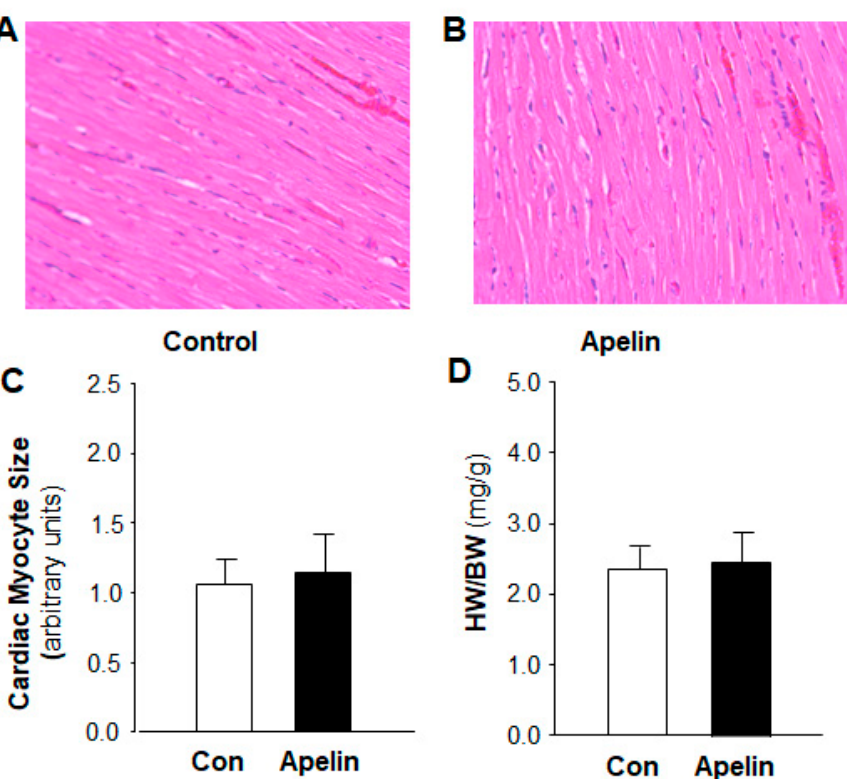
Figure 2. Effect of chronic subcutaneous infusions of apelin on cardiac morphology. The cardiac morphology was examined using H&E staining in the heart sections of rats that received chronic treatment with control (saline) and apelin-13 for two weeks. ( A , B ), micrographs (magnification, 20X) showing representative heart sections stained with H&E in rats that received subcutaneous infusion of saline or [pyr 1 ]-apelin-13. ( C ), bar graphs summarizing the cardiac myocyte area within the cardiac sections in each group of rats. Data are means ± SE from 6 rats in each group ( p > 0.5). ( D ), bar graphs showing the ratio of heart weight versus body weight (HW/BW) in rats that received subcutaneous infusion of saline or [pyr1]-apelin-13. Data are means ± SE from 6 rats in each group ( p > 0.5). It has been reported that APJ receptors share a 31% amino acid sequence identity with AT1 receptors [6]. Therefore, we examined the possibility that apelin could interact with Ang II/AT1 receptors by detecting the chronic effect of apelin on the Ang II-induced pressor response. The results from this experiment are presented in Figure 3, demonstrating that subcutaneous infusions of apelin-13 did not significantly alter Ang II-induced increases in MAP, SAP, DAP, and PAP. Chronic subcutaneous infusions of apelin-13 plus Ang II did not significantly alter HR in these rats. Together, the results from this experiment suggest that, in contrast to apelin, the chronic subcutaneous infusion of Ang II induces a dramatic increase in BP and that apelin has no significant effect on the Ang II-induced pressor response. Chronic administrations of Ang II or apelin had no significant effect on